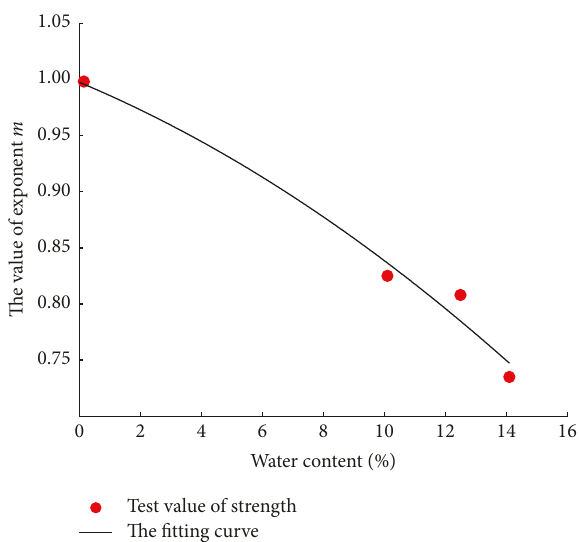
Figure 12: Fitting curve between the value of exponential m and water